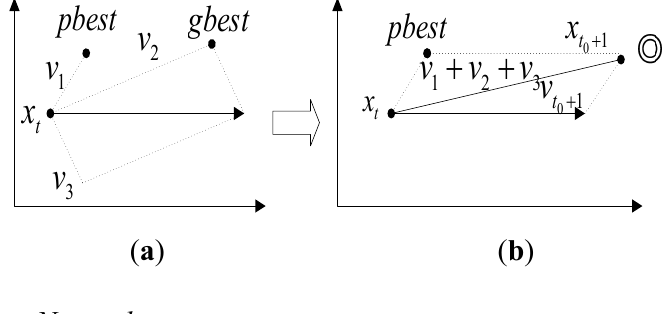
Figure 1. Velocity and position adjustment of particle at time t 0 ( a ) and t 0 + 1 ( b ).